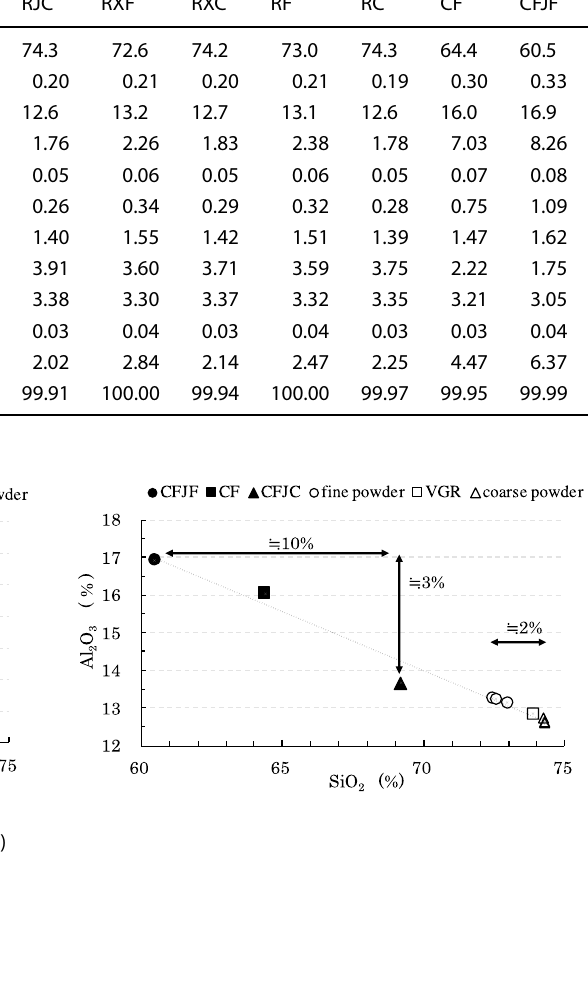
Table 5 Chemical composition and LOI of the materials